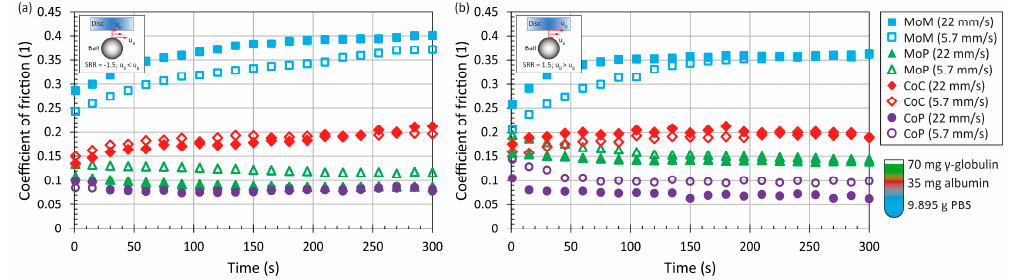
Figure 4. Development of CoF as a function of time for four material combinations at lower and higher mean speed under negative ( a ) and positive ( b ) sliding conditions. Contact is lubricated by model fluid Alb35+Glob70.